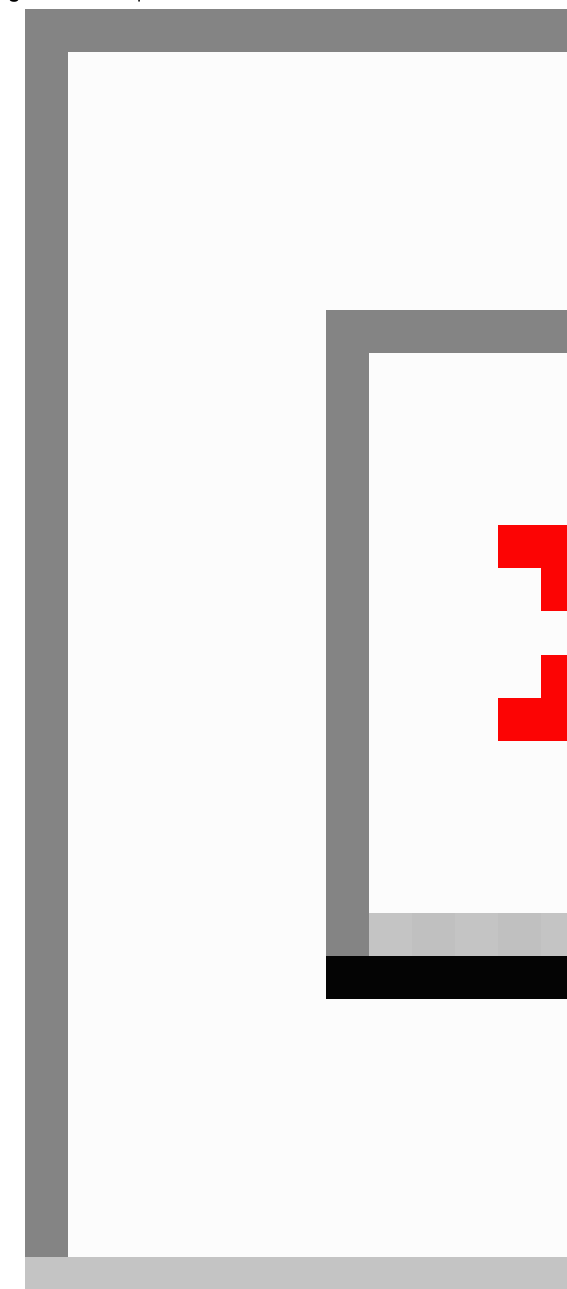
Figure 3. Participant